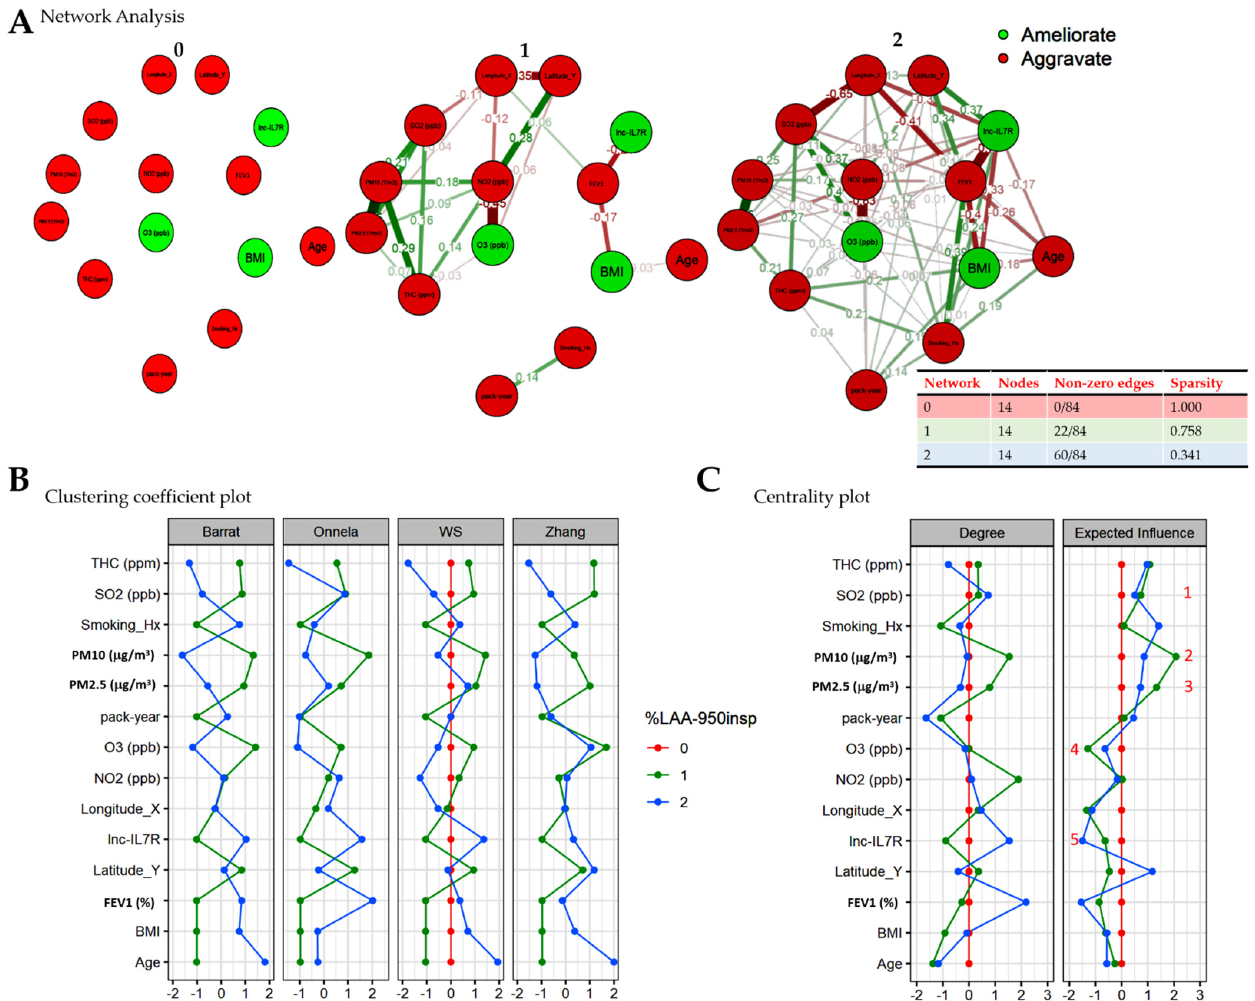
Figure 3. Severity-stratified spatiofunctional interaction between individual predictors of COPD-E progression in Taiwan. ( A ) Visualization, ( B ) clustering coefficient plot, and ( C ) centrality plot of the interaction between indicated variables in the determination of COPD-E severity as shown by bootstrapped network analysis. Number of bootstraps = 1000. red circle, aggravating factor; green circle, ameliorating factor. WS, Watts and Strogatz.